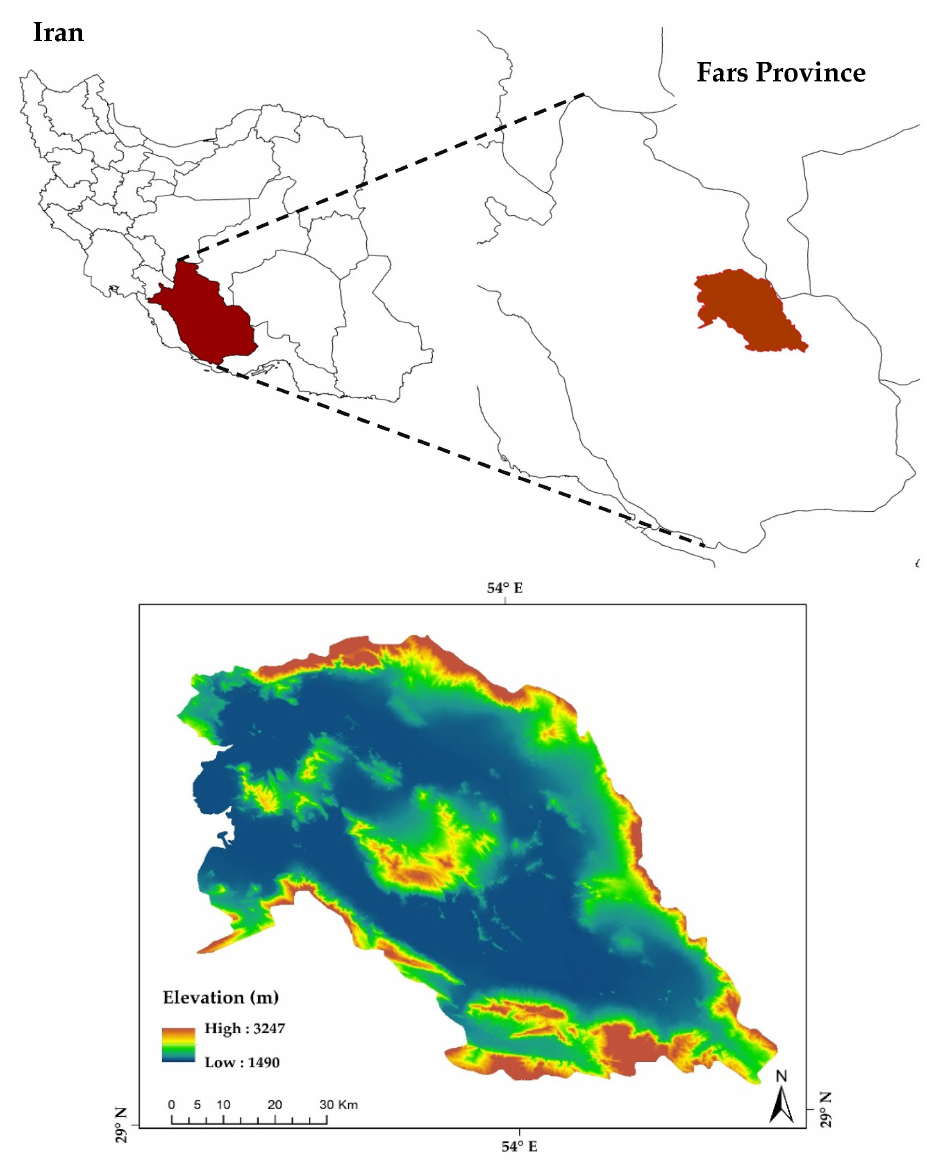
Figure 1. Location of the study area, Bakhtegan basin in Fars Province, southern